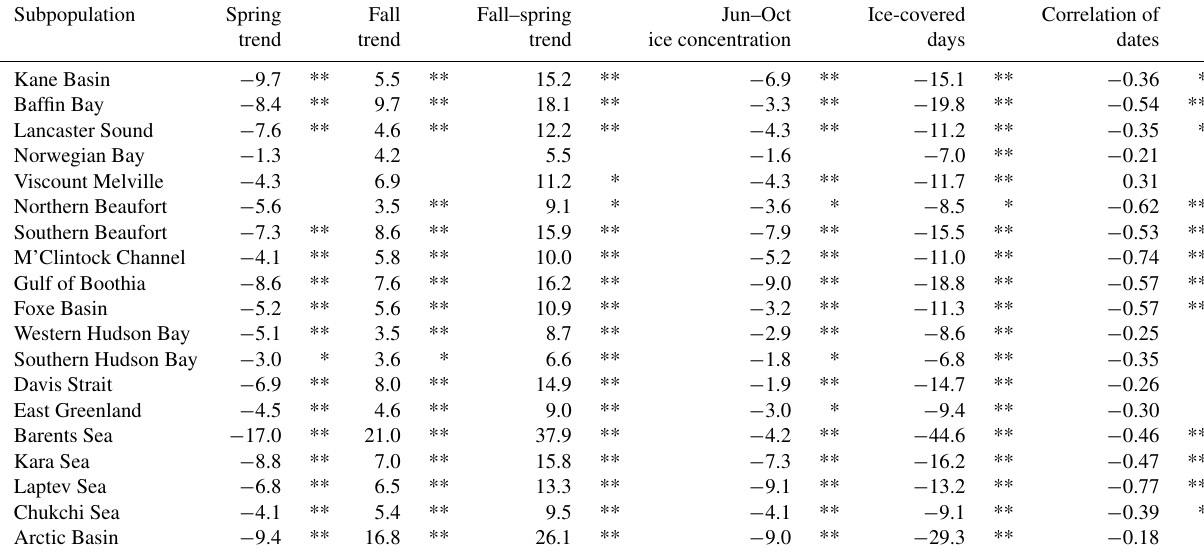
Table 4. Same as Table 3 but for the shallow ( ≤ 300m) portions of each region. Subpopulation Spring Fall Fall–spring Jun–Oct Ice-covered Correlation of trend trend trend ice concentration days dates Kane Basin